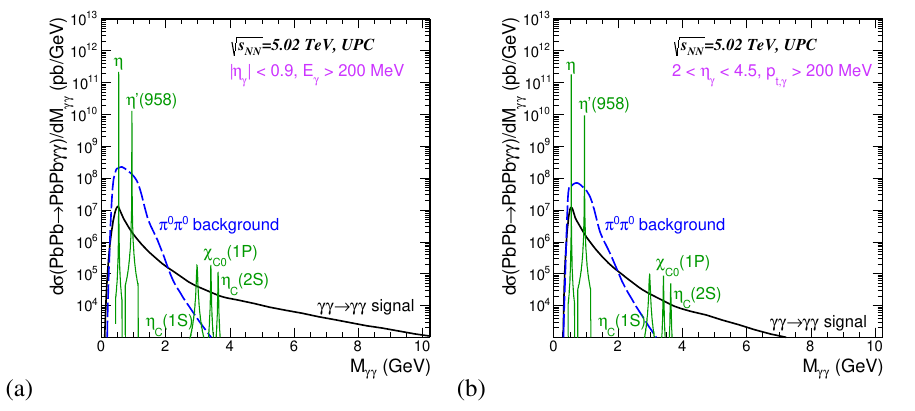
Figure 7. Di ff erential nuclear cross section for PbPb → PbPb γγ as a function of γγ invariant mass. (a) ALICE and (b) LHCb kinematical cuts are included. In addition, the energy experimental resolution √ s NN = 5 . 02 TeV. is taken into account. Here